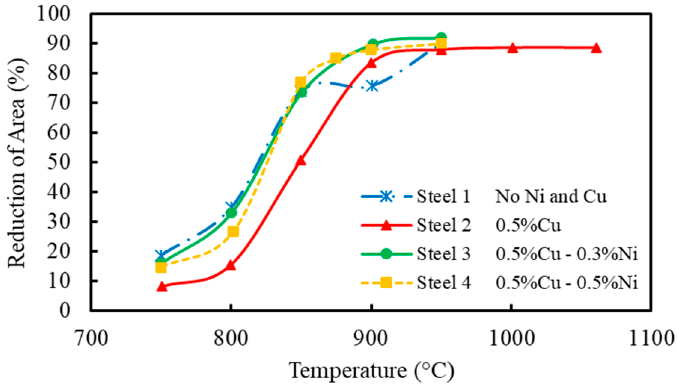
Figure 1. Hot ductility for steels tested under an argon atmosphere at the slow cooling rate of 25 K/min showing that a Cu addition impairs ductility while adding Ni restores ductility.